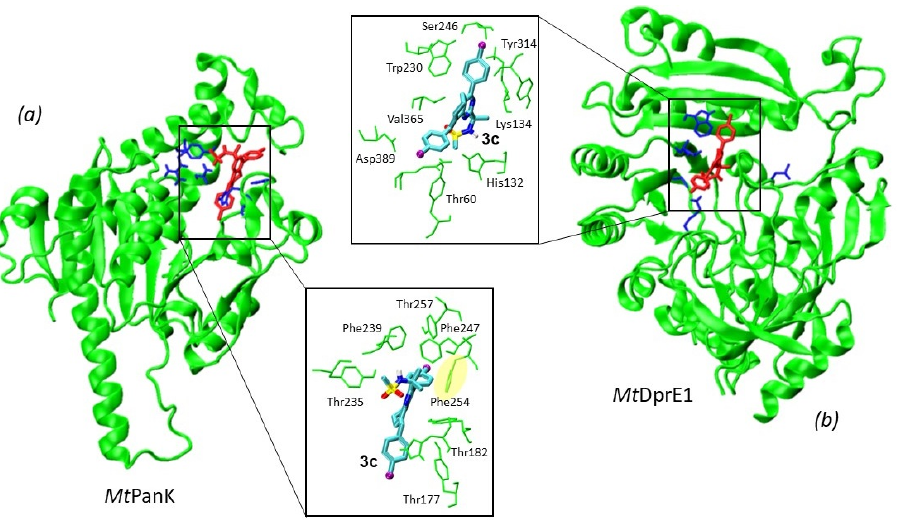
Figure 3. The best-scored docked pose of 3c bound to Mt PanK (PDB code 4BFT) ( a ) and Mt DprE1 (PDB code 4FF6) ( b ), respectively. The active site residues are shown in blue as follows: Mt PanK—residues Tyr177, His179, Tyr282, Tyr235, Arg238, and Asn277; Mt DprE1—residues Ile115, Gly117, Trp230, Leu363, Val365, Cys387, and Lys418 [31], respectively. Ribbon representation of the structure of the enzyme- 3c complex. The protein is shown as a ribbon model in green and 3c is represented as a licorice model in red. Inserts outline the protein–ligand interactions of 3c with neighboring enzyme residues.